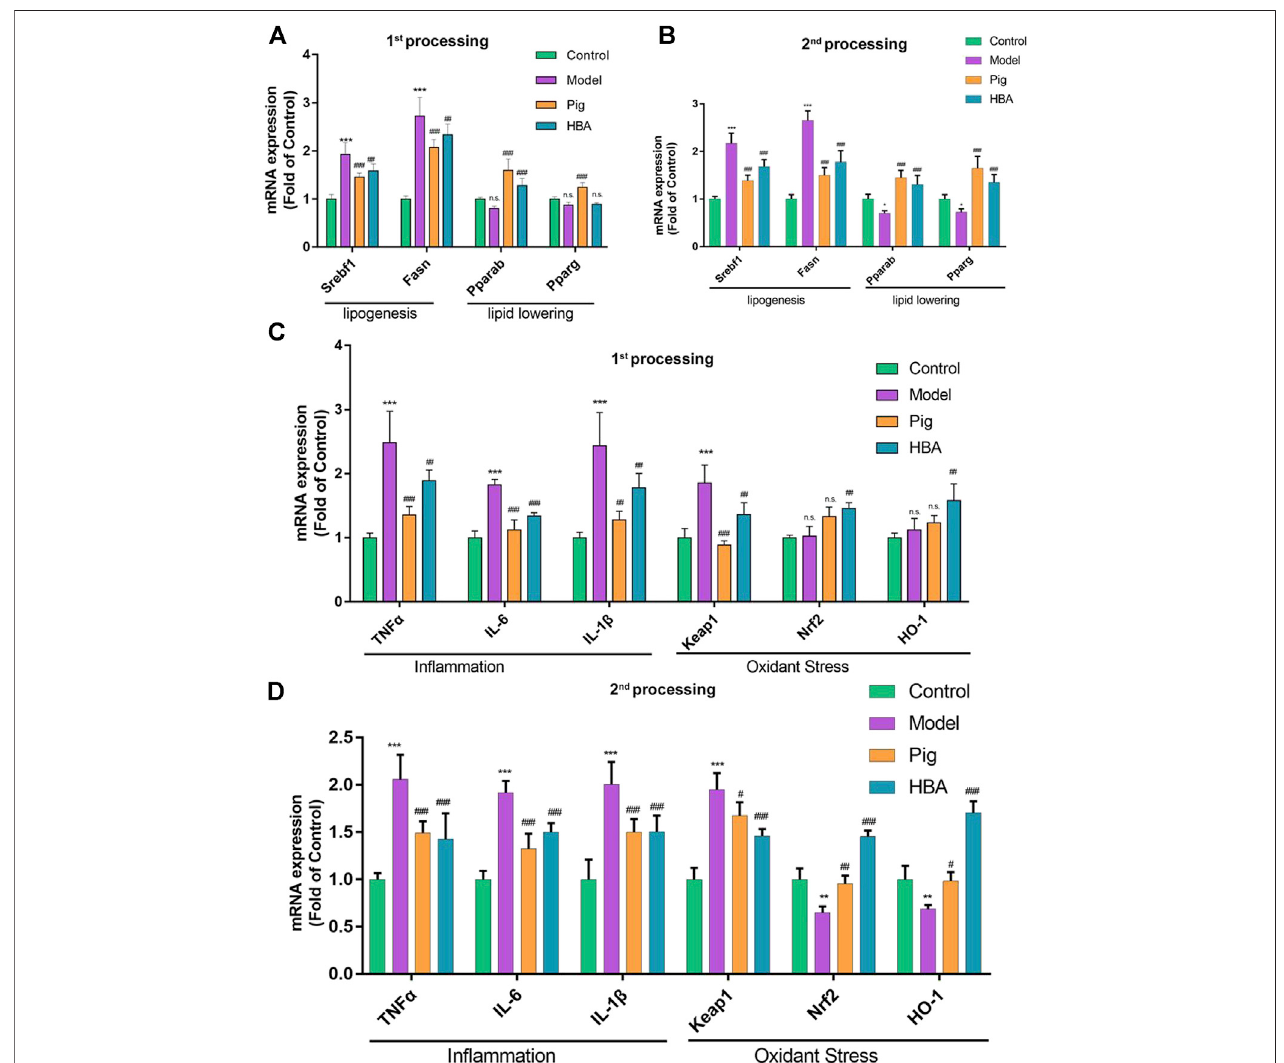
FIGURE4 | Liver mRNA Expression Changes HBAon the Larval Zebra fi sh Model. (A,B) thegene expression level of lipogenesis and lipid-loweringof each treated larval zebra fi sh group in the fi rst process B in the second process. (C,D) the gene expression level of in fl ammation and oxidant stress of each treated larval zebra fi sh group in the fi rst process D in the second process. Bars indicate means ± SD. n. s. indicate no signi fi cant; * p < 0.05** p < 0.01*** p < 0.001 represent compared with the control; # p < 0.05, ## p < 0.01, ### p < 0.001 represent compared with Model. p < 0.05 was considered as statistically signi fi cant calculated by One-way ANOVA followed by Tukey ’ s test ( n (cid:1) 3, n indicates the replicates of the